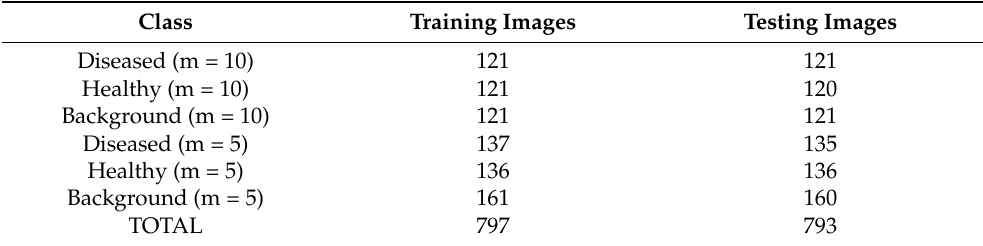
Figure 3. Overall SLIC Segmentation and Superpixels Dataset Generation Workflow. Table 2. Dataset distribution for training deep learning models for identifying diseased regions using SLIC segmentation.